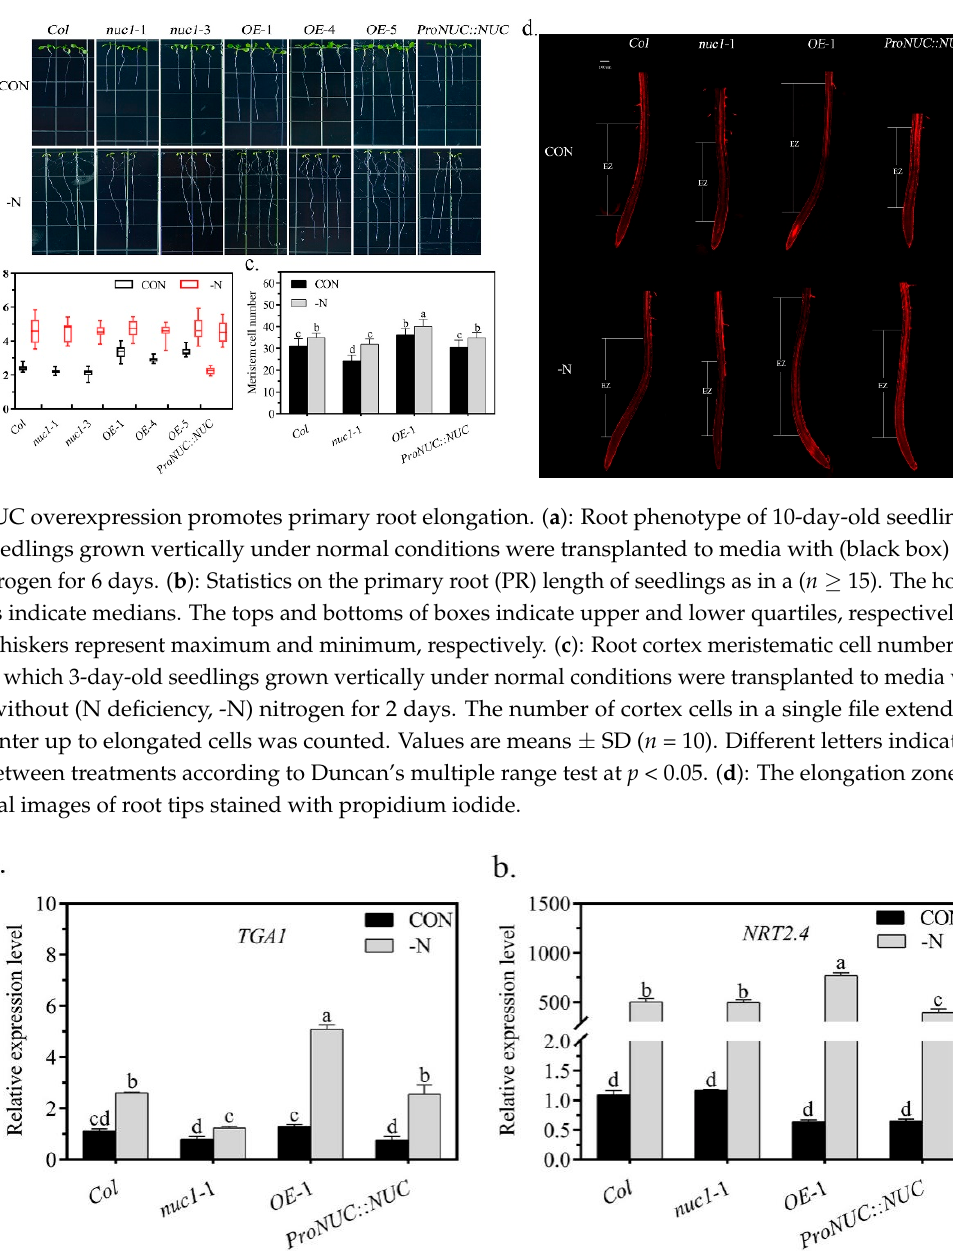
Figure 5. NUC regulated expression of nitrate-responsive genes. ( a ): TGA1 . ( b ): NRT2.4 . Values are the means ± SDs ( n = 3). Different letters indicate significant difference between treatments according to Duncan’s multiple range test at p < 0.05.